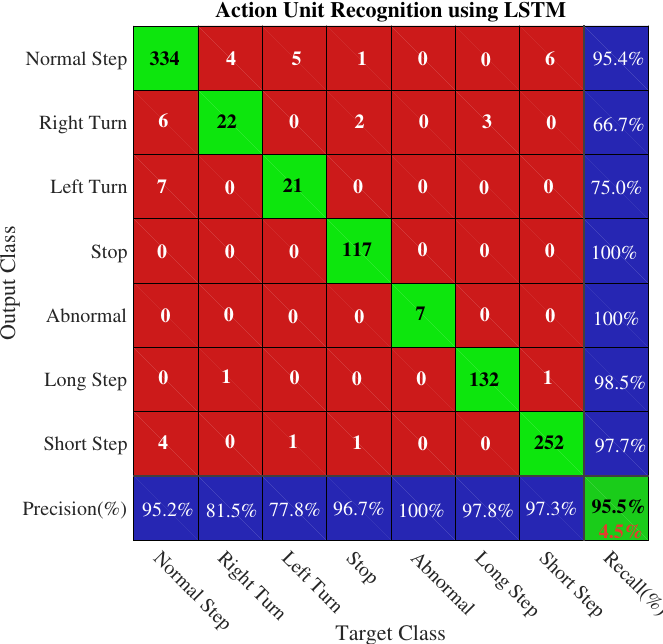
Figure 12. Confusion matrix representing the LSTM performance for AU recognition (test